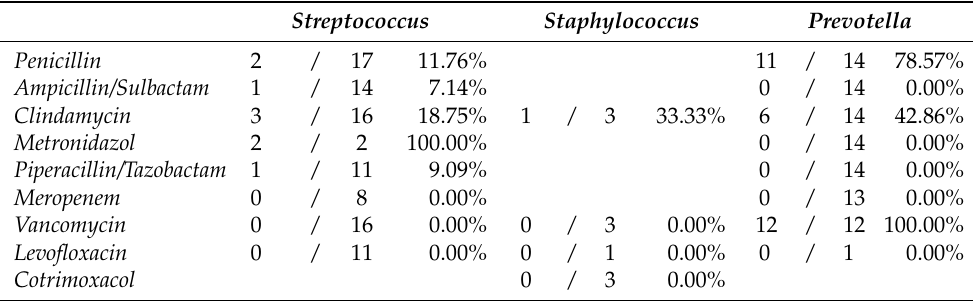
Table 2. Resistance to the bacterial genera cultivated in this study. For the three most frequent genera, the absolute and relative amounts of resistance were determined. The genus Prevotella , which showed by far the highest frequency in the microbiome, showed resistance to penicillin in 79% of cases and clindamycin in 43% of